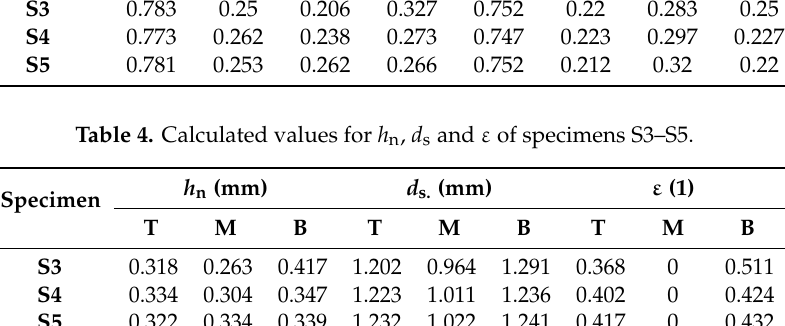
Figure 8. ( a ) The method of estimating local equivalent strain in specimen S5; and ( b ) mean and local equivalent strain distribution in the specimen S5. Table 3. Calculated values for V and h of specimens S3–S5.